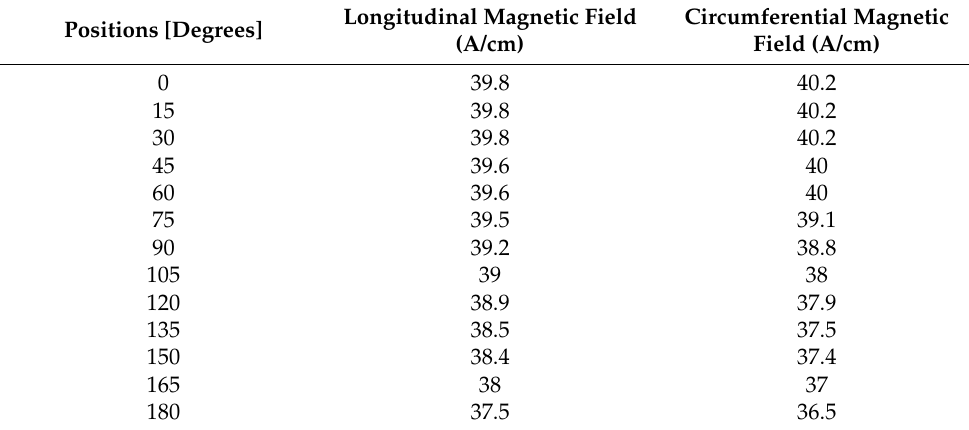
Table 1. Changes in the tangential magnetic field